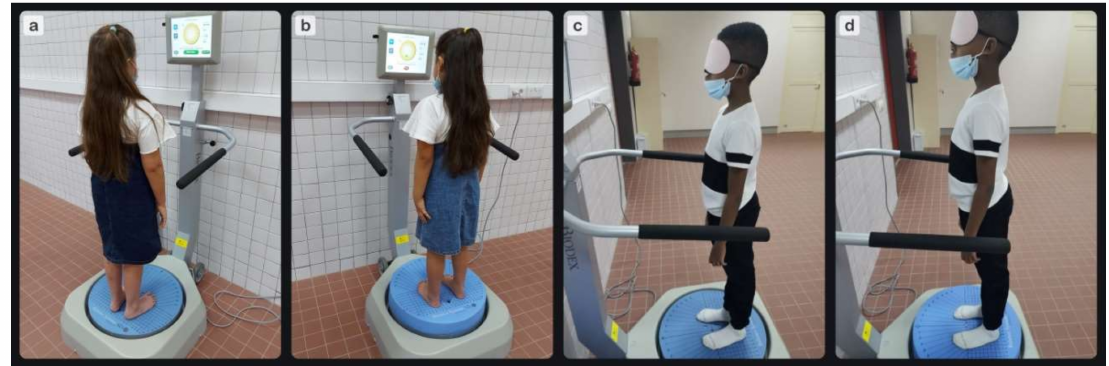
Figure 2. This is a figure for the testing procedures. ( a ) Eyes open/firm surface, ( b ) eyes open/foam, ( c ) eyes closed/firm surface, ( d ) eyes closed/foam.